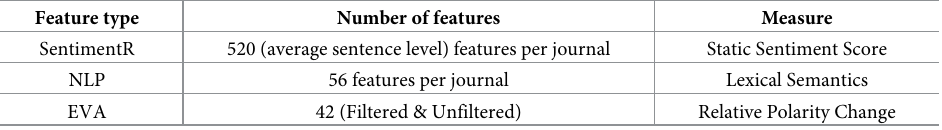
Table 2. A tabulation of features used in this study.